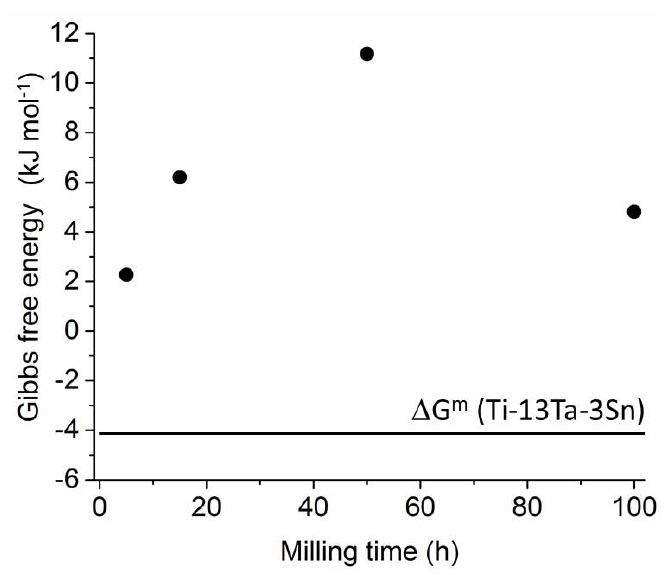
Figure 4. Evolution of Gibbs free energy as a function of milling time for the Ti-13Ta-3Sn alloy.